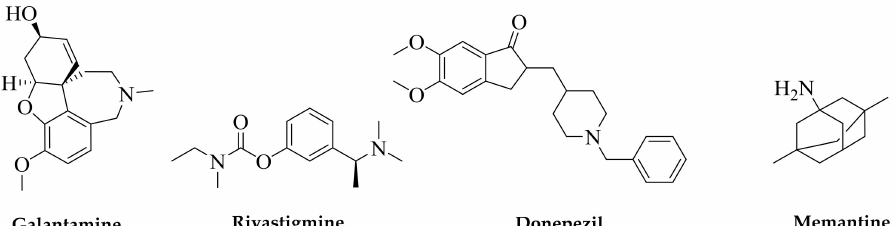
Figure 1. Current drugs of choice for Alzheimer’s disease (AD) therapy. Natural products are at the forefront of drug discovery for AD as galantamine was first isolated from the bulbs of the common snowdrop plant Galanthus nivalis . Isolated from the West African Calabar bean, physostigmine has been the prototype acetylcholinesterase (AChE) inhibitor, but its short duration of e ff ect for AD and tacrine’s toxicity initiated the search for safer drugs; this led to the discovery of donepezil as a synthetic AChE inhibitor. Memantine acts through a di ff erent mechanism of action and was obtained from the synthesis